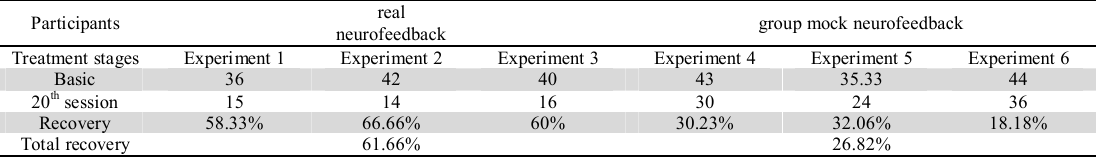
The results of HRSD for two groups Participants Treatment